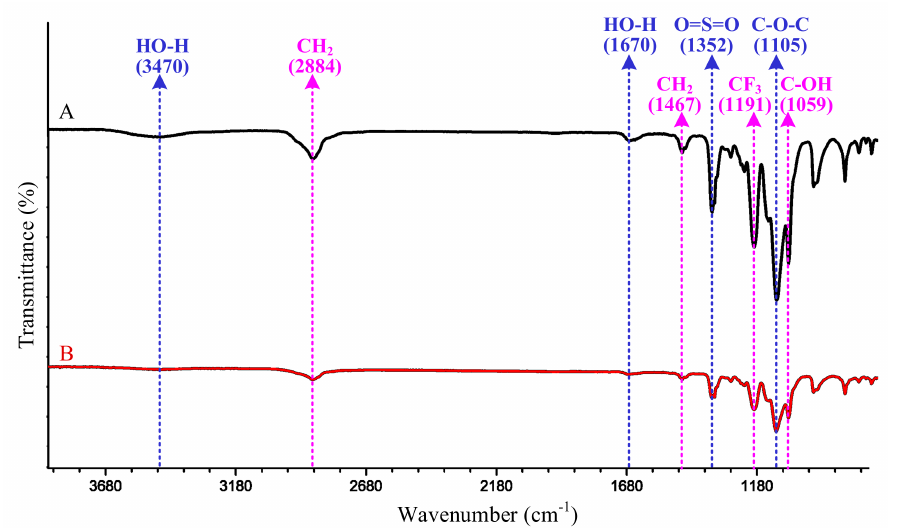
Figure 14. FTIR test results of the